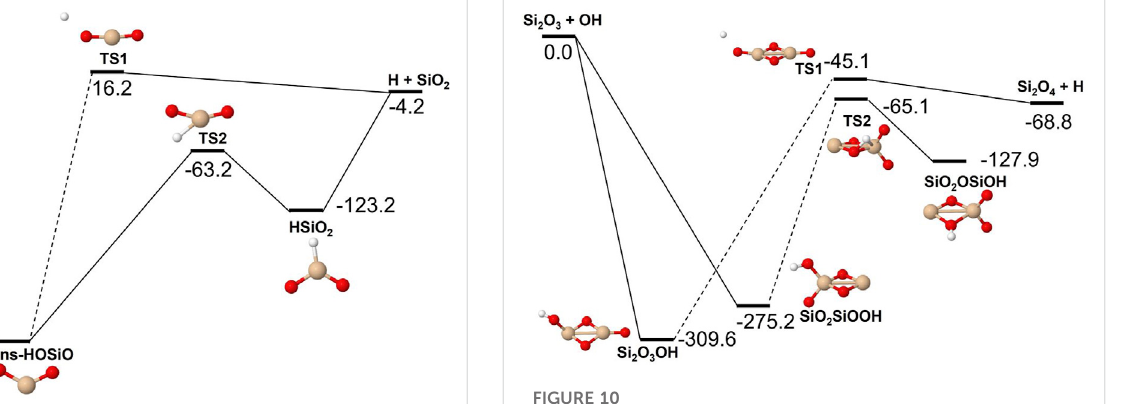
FIGURE 10 Potential energy surfacebased on M06 calculations for theSi 2 O 3 +OHreactionasimplementedintheRRKMcalculations.Theenergies are given in kJ/mol and include zero-point energy corrections. Dashed lines indicate that the reaction step has been simpli fi ed by combining several similar intermediate